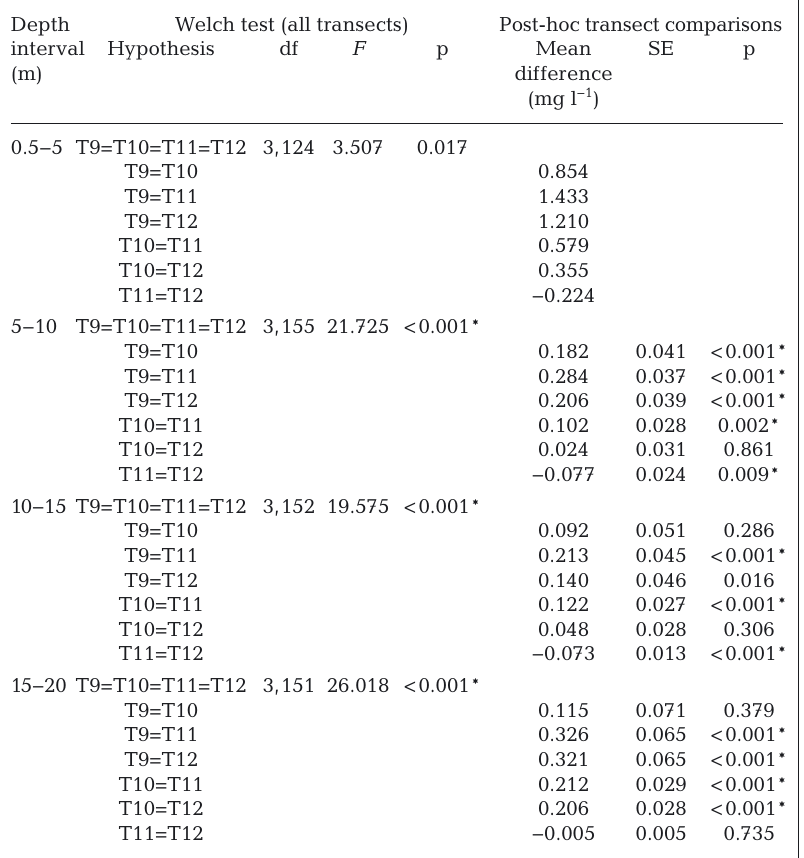
Table 3. Welch ANOVA and post-hoc test results of mean concentrations of total par- ticulate matter (mg l −1 ) between sampling transects at the Charlie Cove salmon farm on 7 July, 2011. The location of each transect (T9 to T12) is shown in Fig. 3D, and ANOVA comparisons are for the indicated transects and depth ranges. *Significant at α =